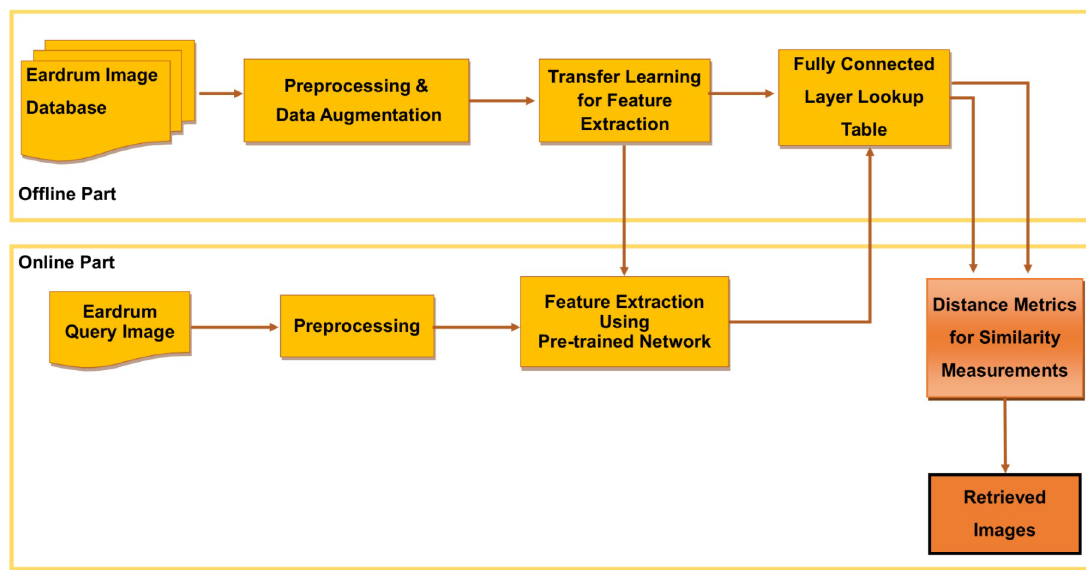
Fig 1. Block diagram showing the workflow of the OtoMatch